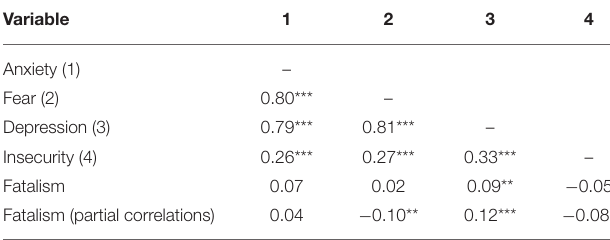
TABLE 3 | Bivariate correlations among fatalism and negative emotions.